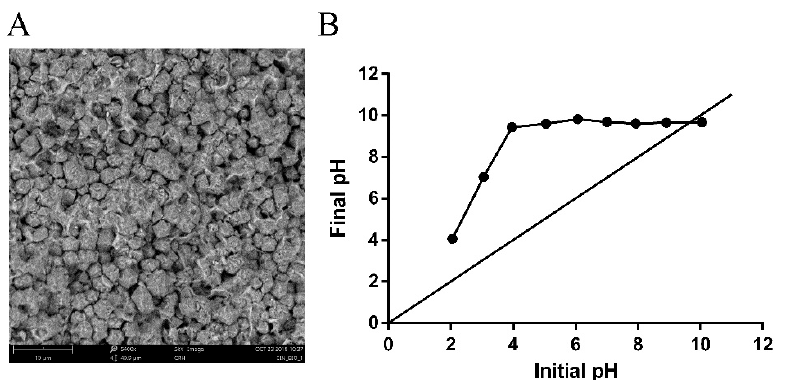
Figure 3. Zeolite characterization by SEM ( A ) and by pH drift method ( B ).